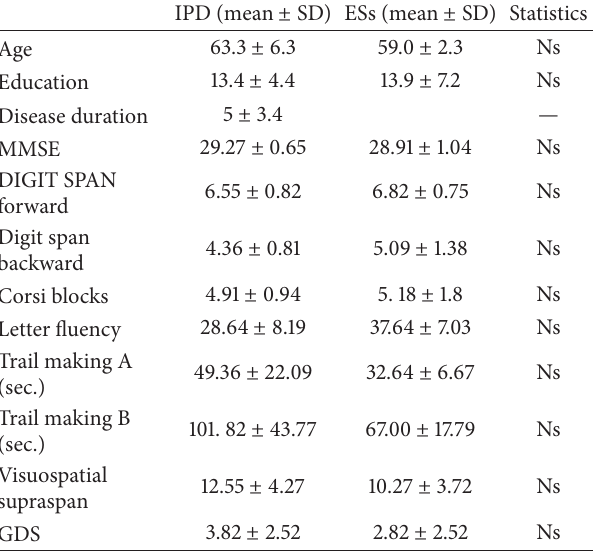
Table 1: Clinical and demographic data of IPD patients and healthy volunteers (ESs) (mean ±